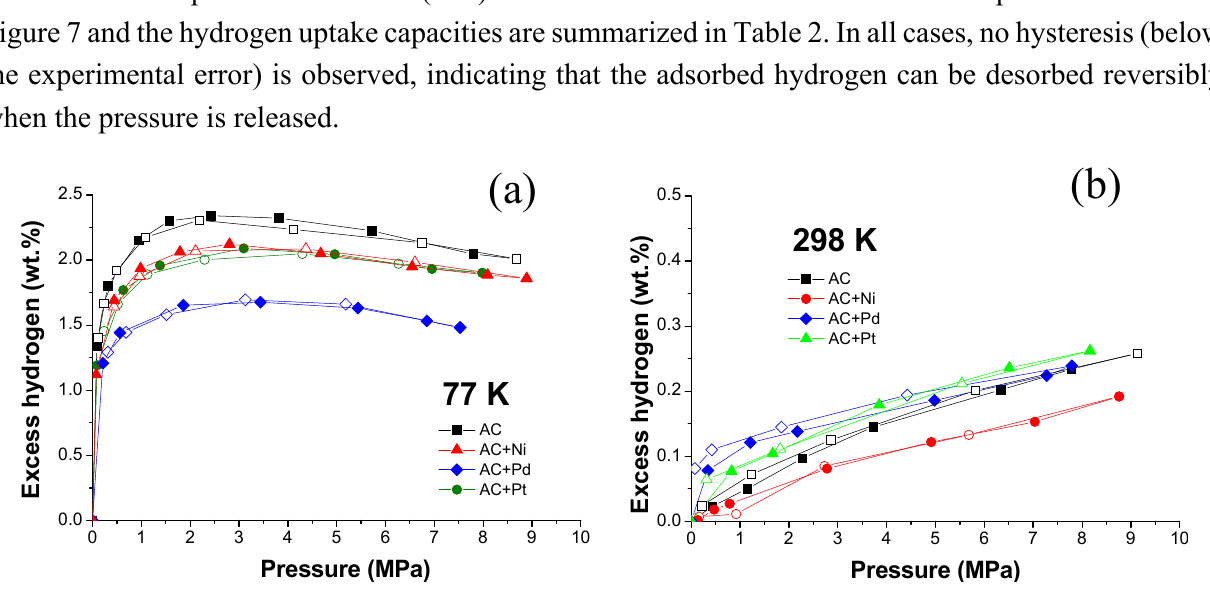
Figure 7. Pressure composition isotherm curves at ( a ) 77 K and ( b ) 298 K for the activated carbon (AC), Ni- , Pd- and Pt-anchored AC. Full and empty symbols stand for adsorption and desorption measurements,